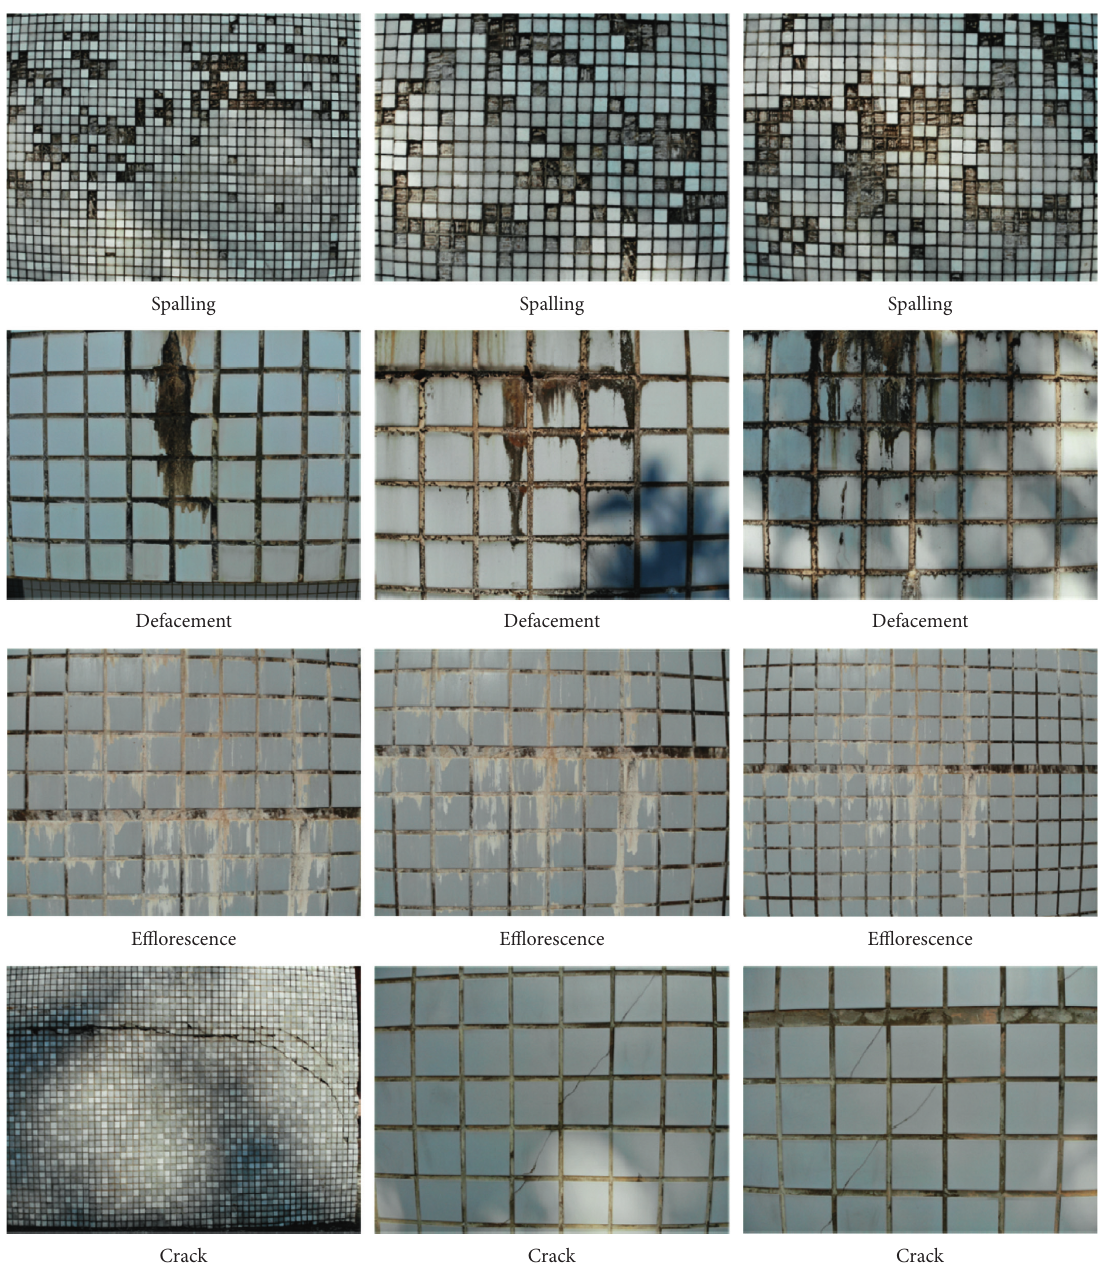
Figure 1: Examples of the training dataset